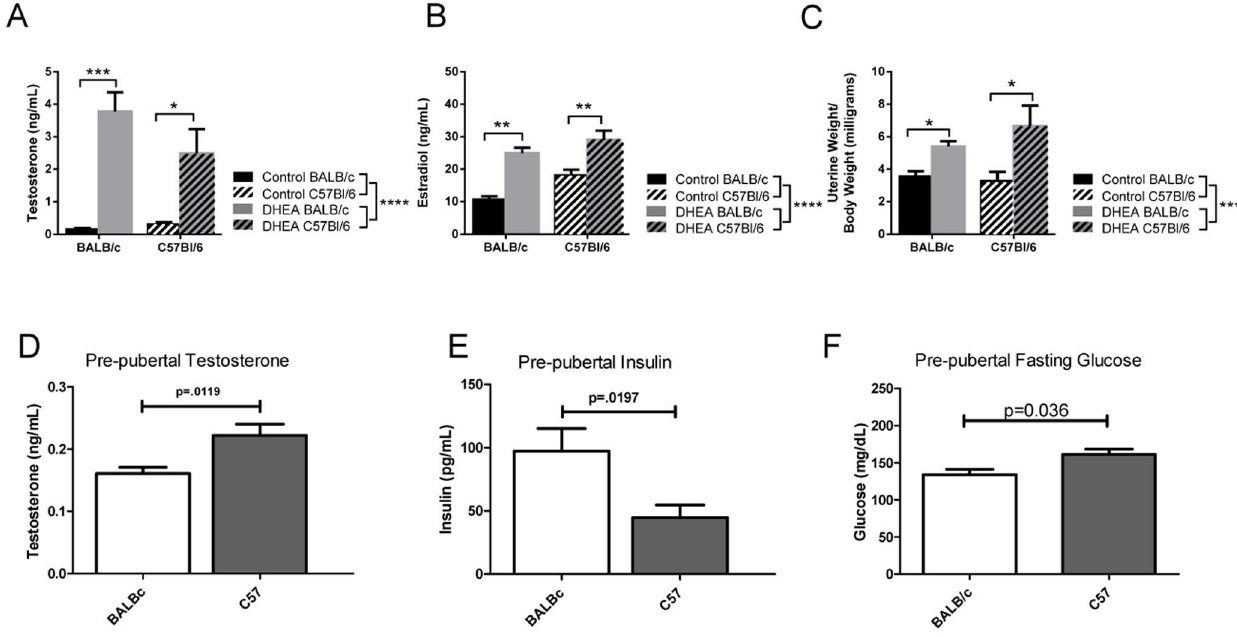
Figure 1. Hyperandrogenemia is induced by DHEA administration. A. Terminal serum testosterone levels. B. terminal serum estradiol levels C. Uterus weight compared to body weight upon dissection. D. Prepubertal testosterone levels. n=8 E. Prepubertal fasting glucose. F. Prepubertal insulin levels. n=7–9 for BALB/c groups and n=9–10 in C57 groups. * means p , 0.05, ** means p , 0.01, *** means that p , 0.001. ANOVA main effects are shown by the legend while the post hoc comparisons are over the column bars.